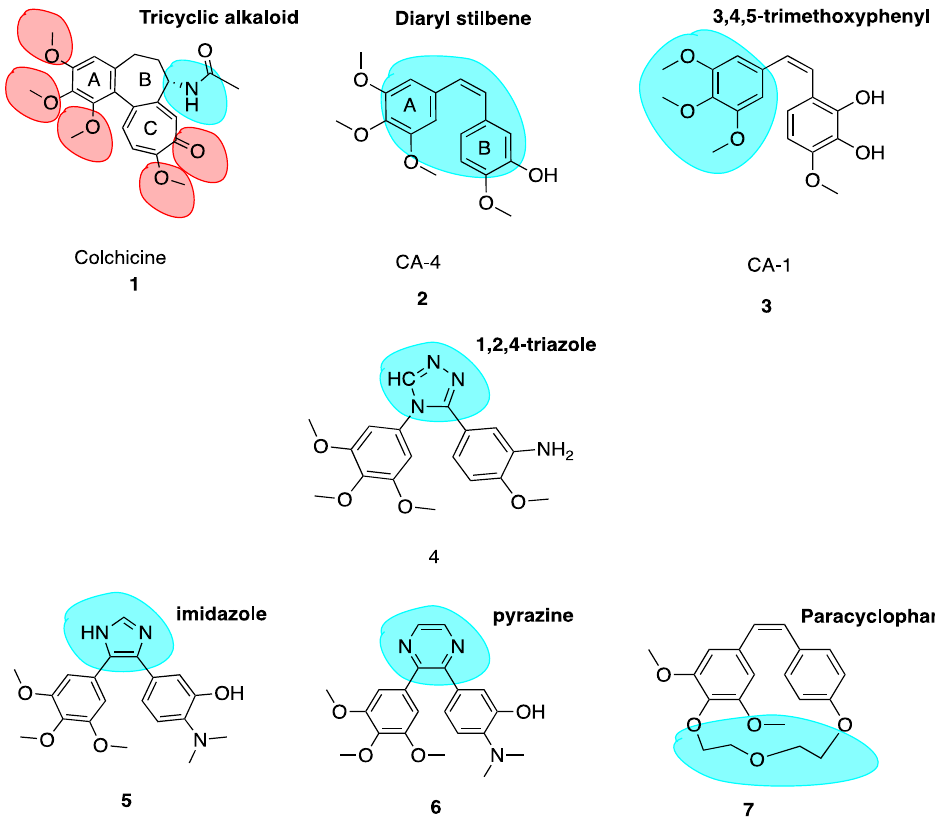
Figure 3. Structures of colchicine, combretastatin A-4, combretastatin A-1 and analogues 4–7.